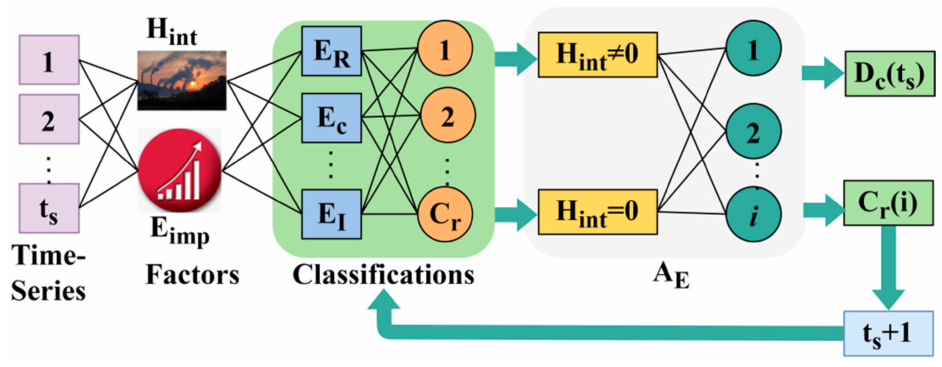
Figure 3. Learning for Classifying Actual Energy Observed from Sources A E